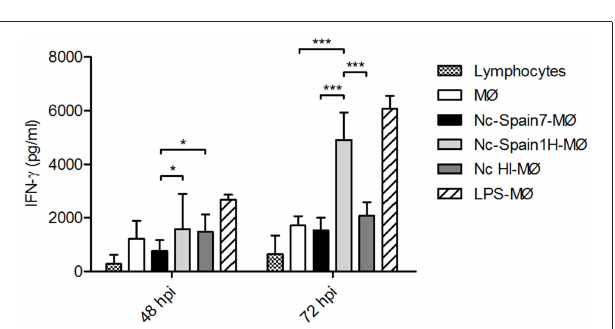
FIGURE 9 | IFN-gamma production by lymphocytes in co-culture with N. caninum -infected MØs. The graph represents the concentration of IFN- γ in supernatants obtained from lymphocytes in co-culture with non-infected MØs (MØ) or MØs challenged with N. caninum Nc-Spain7 (Nc-Spain7-MØ), Nc-Spain1H (Nc-Spain1H-MØ), heat-inactivated tachyzoites (Nc HI-MØ) or 100 ng ml − 1 LPS (LPS-MØ). Each column and error bar represents the mean and SD of three replicates from three independent experiments. Significant differences are indicated (* p < 0.05; *** p < 0.001). IFN- γ was not detected in samples without lymphocytes, and lymphocytes without macrophages (lymphocytes) reached average IFN- γ values lower than 1,000 pg ml − 1